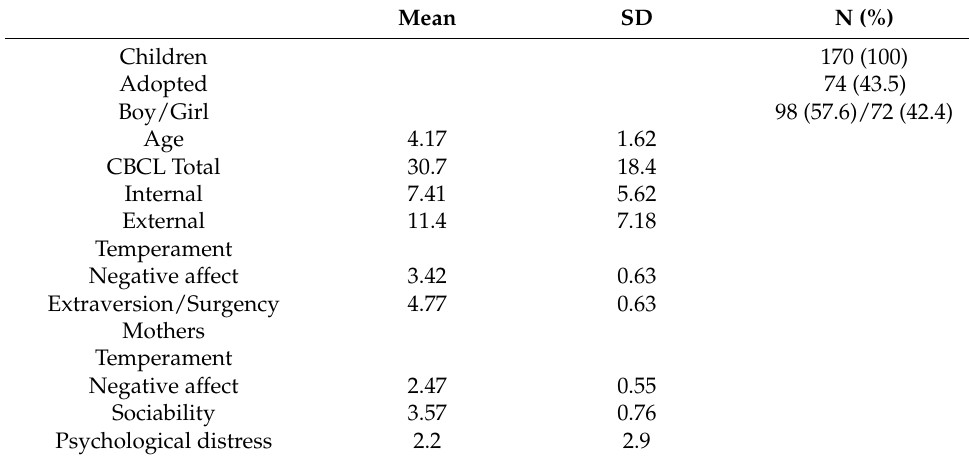
Table 1. Descriptive